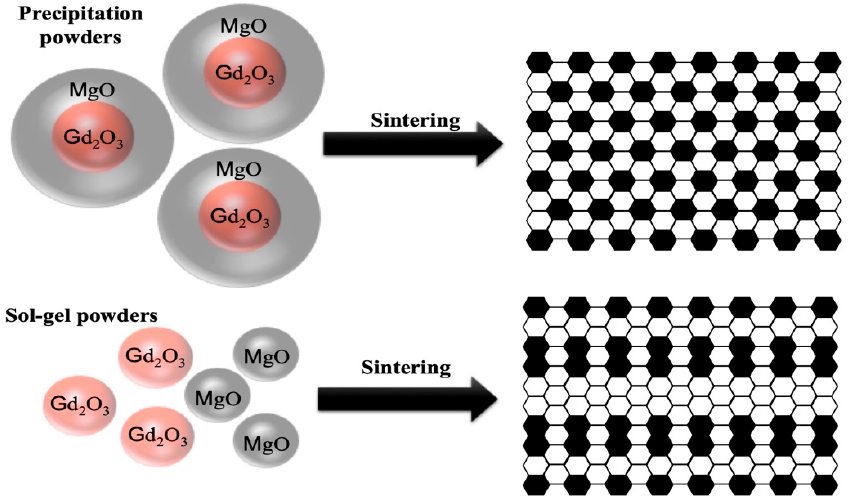
Figure 5. Diagrammatic sketch of the phase domain and grain size evolution during the sintering of composite materials using different nanopowders.